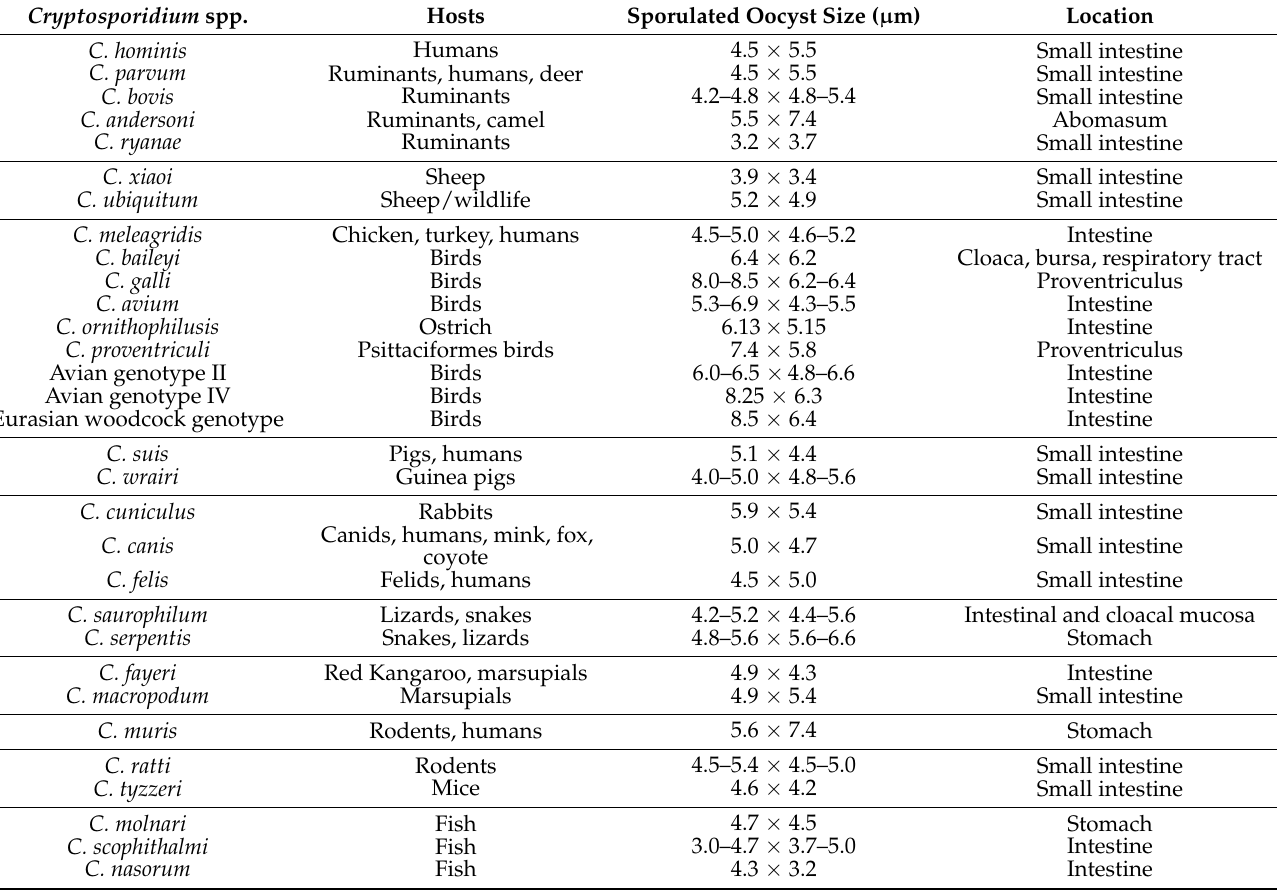
Table 1. Most predominant Cryptosporidium species: major hosts, oocyst sizes and locations [18,58,73–76]. Cryptosporidium